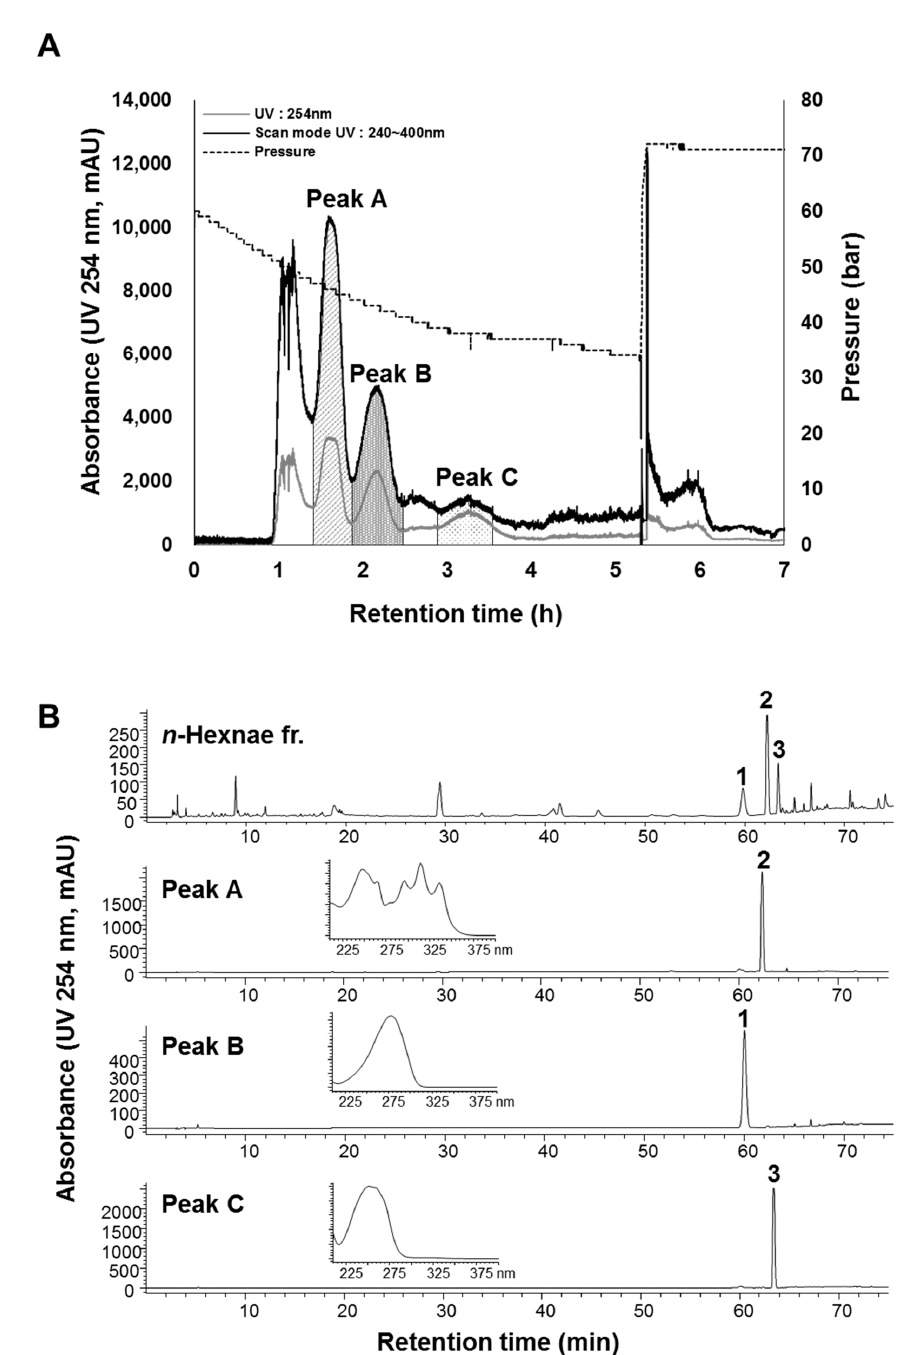
Figure 3. CPC chromatogram of the n -hexane fraction ( A ) and HPLC chromatograms and UV spectra of the n -hexane fraction and purified peaks (A–C) ( B ). CPC conditions: two-phase solvent system, n -hexane–ethyl acetate–methanol–water (8:2:8:2, v / v ), descending mode; mobile phase, lower (more hydrophilic) phase; flow rate, 10 mL/min; rotation speed, 1100 rpm; monitored at 254 nm and scan mode (240–400 nm). Peak A : (6 E ,12 E )-tetradeca-6,12-diene-8,10-diyne-1,3-diol diacetate ( 2 ), peak B : atractylenolide I ( 1 ) and peak C : selina-4(14),7(11)-dien-8-one ( 3